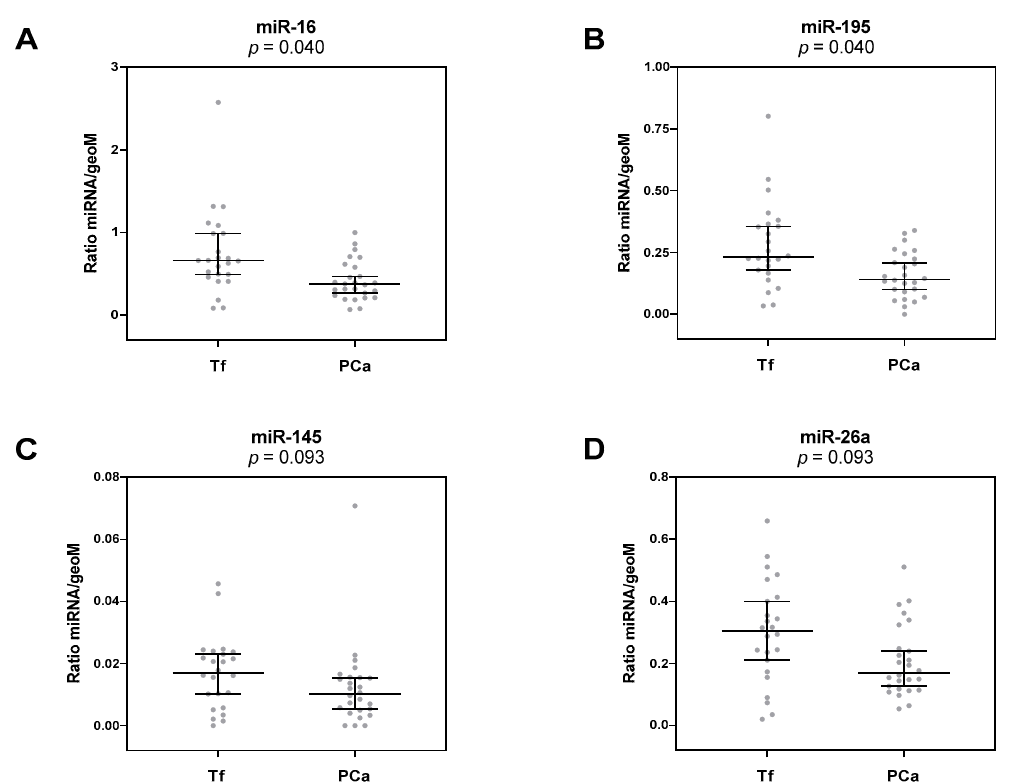
Figure 1. Relative expression levels of ( A ) miR-16, ( B ) miR-195, ( C ) miR-145, and ( D ) miR-26a in urinary sediments from Tf and PCa groups. Depicted are the median relative transcript levels ± 95% CI of the evaluated miRNAs (normalized to the geometric mean of reference RNAs RNU44 and RNU48) in Tf and PCa groups. p values were calculated by the Mann–Whitney U test and then corrected for multiple comparisons by the Benjamini–Hochberg method.